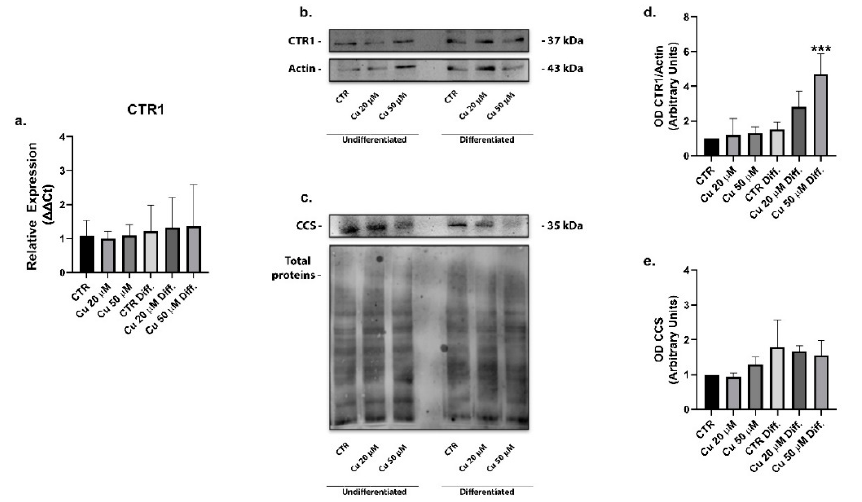
Figure 6. Copper treatment increased copper transporter protein 1 (CTR1) expression in differen- tiated SHSY5Y cells. mRNA relative expression of the transporter CTR1 in undifferentiated and differentiated cells incubated with 20 or 50 µ M copper ( a ). Representative immunoblots of the CTR1 ( b ) and copper chaperone for superoxide dismutase (CCS) ( c ) protein levels and densitometric analysis of bands representing means ± SD, respectively, of five ( d ) and three ( e ) independent ex- periments. β -actin was used as loading control for CTR1 ( b ), CCS levels were normalized on total protein (c). Values were compared with untreated cells (CTR) by one-way ANOVA following Tukey test *** p <